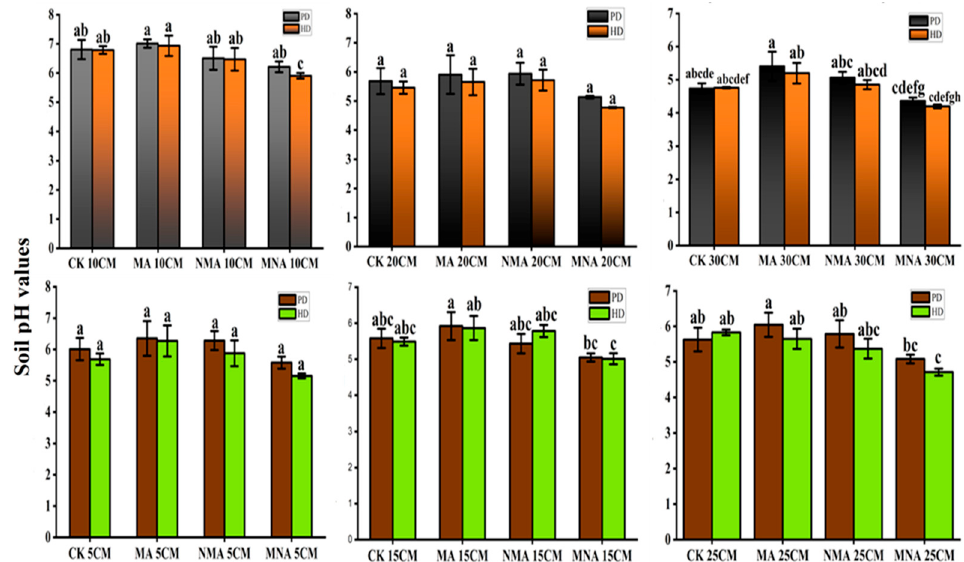
Figure 4. Effects of soil depth ( top row ) and distance from plant trunk ( bottom row ) on soil pH condition. The bars are the standard error of the replications while the different letters on the bars indicate significant differences at p < 0.05.